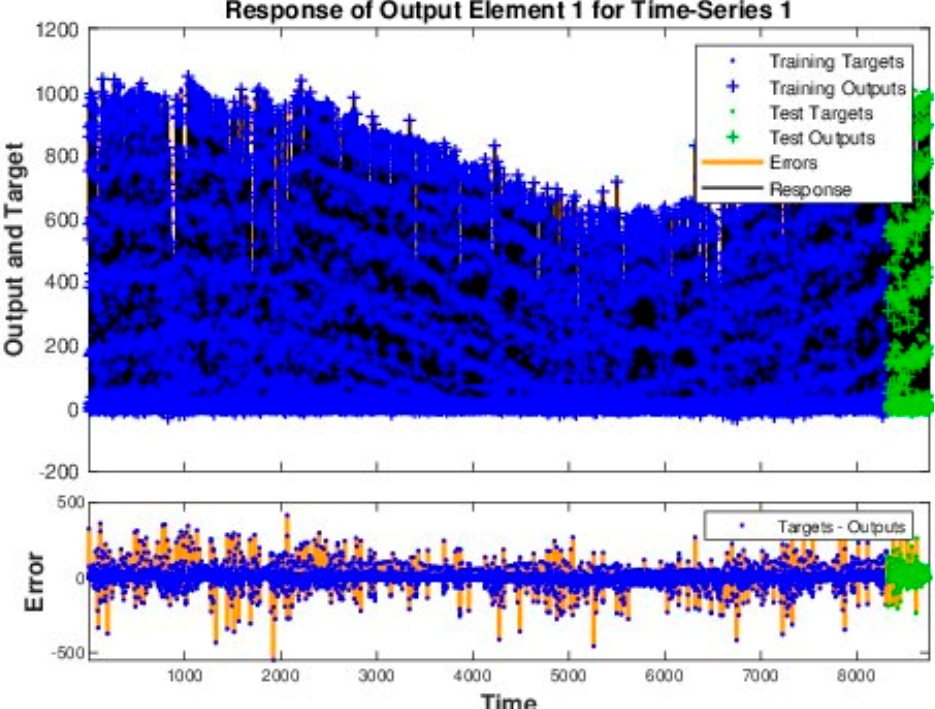
Figure 15. Time series plot of neural network (solar irradiance forecasting case).